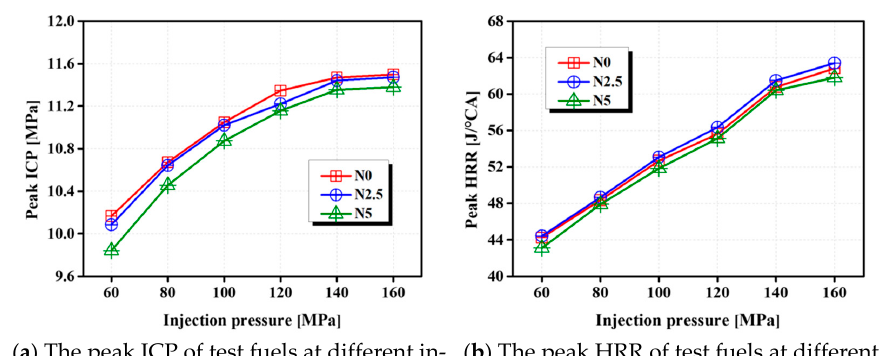
Figure 3. Variation of peaks ICP and HRR with respect to injection pressure for n -octanol/diesel blends.